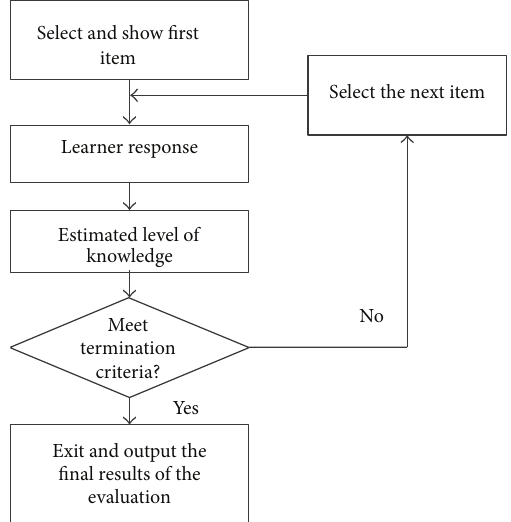
Figure 3: Adaptive testing flow